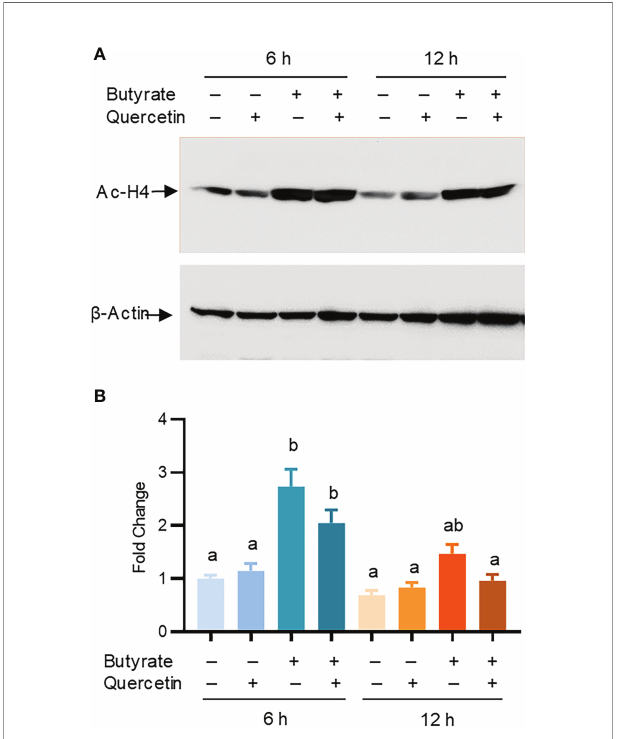
FIGURE 7 | Role of histone acetylation in AvBD9 induction by butyrate and quercetin. Chicken HTC cells were treated with 2 mM sodium butyrate or 20 m M quercetin individually or in combination for 6 or 12 h, followed by western blot analysis of acetyl-histone H4 (Ac-H4) and b -actin. (A) A representative of two independent blots. (B) Fold changes in the acetylation of histone H4 relative to unstimulated cells. Results are presented as means ± SEM of two independent experiments normalized against b -actin. The bars not sharing common superscript letters are signi fi cantly different ( P < 0.05) as determined by one-way ANOVA and post hoc Tukey ’ s